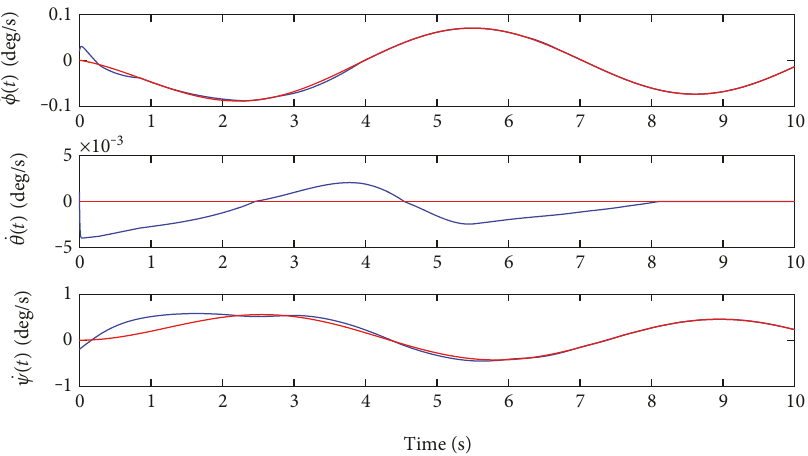
Figure 9: Model reference (red) and actual state (blue) during closed-loop controller operation in the presence of 35.75% SJA parameter